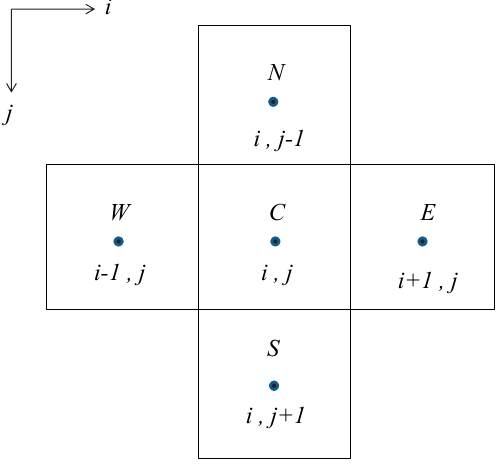
Figure A2. The rule for naming grids.